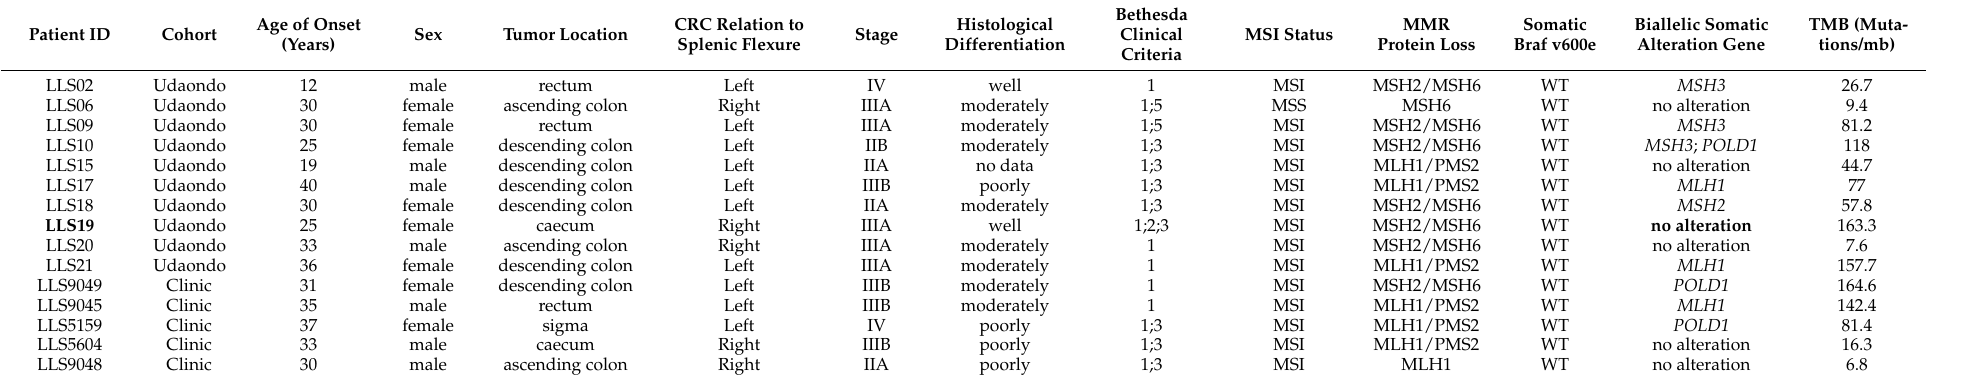
Table 1. Clinical and-pathological features of the colorectal cancer (CRC) Lynch-like syndrome